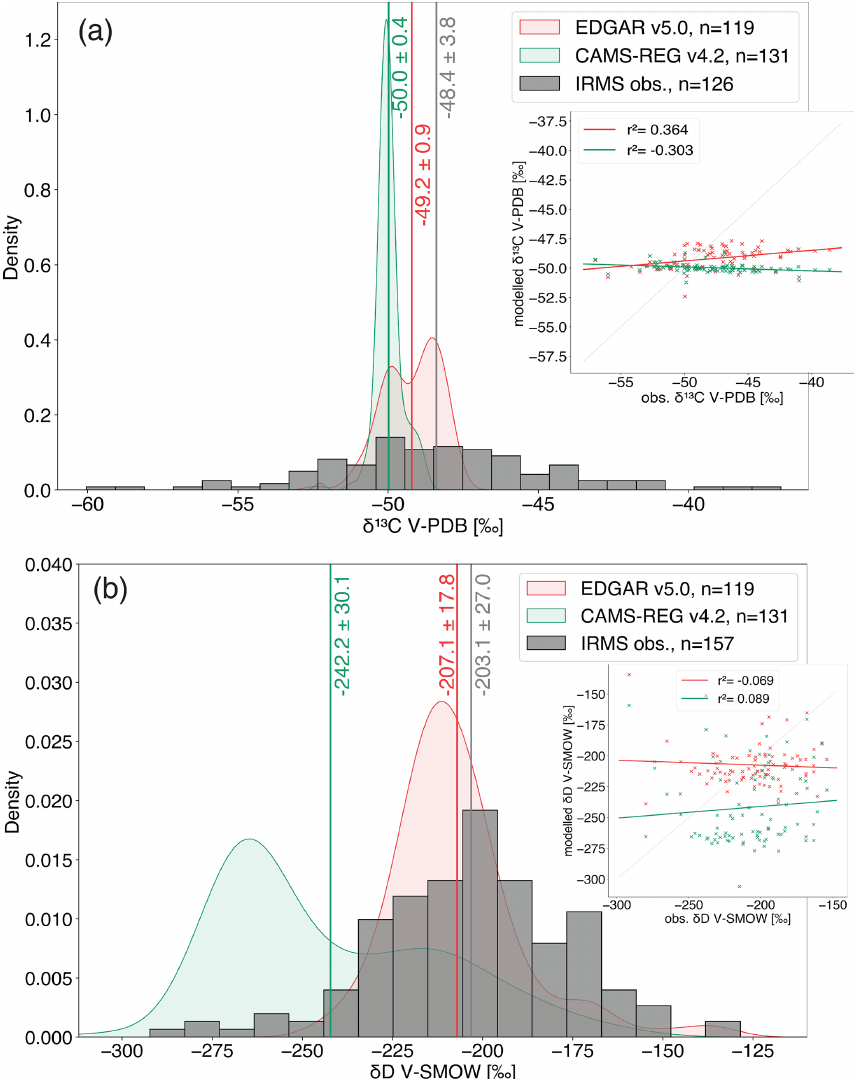
Figure 8. Distribution of source signatures of all peaks and in the inset the correlation between modelled and observed ones. The vertical lines show the average values of each distribution ( ± 1 σ ). (a) δ 13 C signatures in the observed time series (grey, n = 126), modelled using EDGAR v5.0 (red, n = 119), and modelled using CAMS-REG-GHG v4.2 (green, n = 131) time series. (b) δ 2 H signatures in the observed time series (grey, n = 157), modelled using EDGAR v5.0 (red, n = 119), and modelled using CAMS-REG-GHG v4.2 (green, n = 131) time